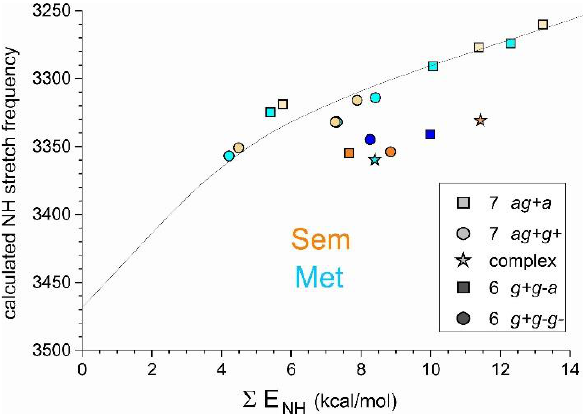
Figure 7. Calculated NH stretch frequency (scaled harmonic frequencies) vs. the total stabilization energy (noted Σ E NH ), taking into account all the interactions that contribute to the electron delocalization towards the σ * NH interaction, for the NH groups involved in an NH···Se-S interaction. Finally, the present data allow us to range the Sem-Met 7 δ and 6 δ H-bonds with re-